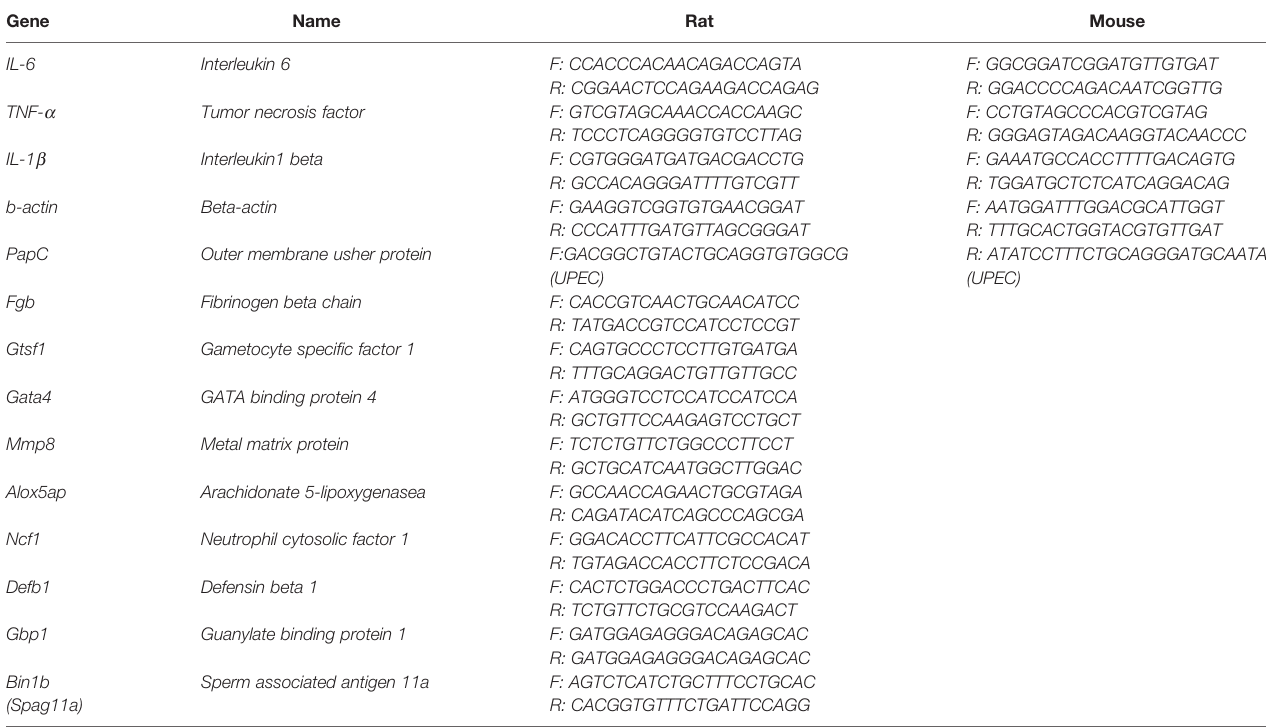
TABLE 1 | The primer sequence information of all involved